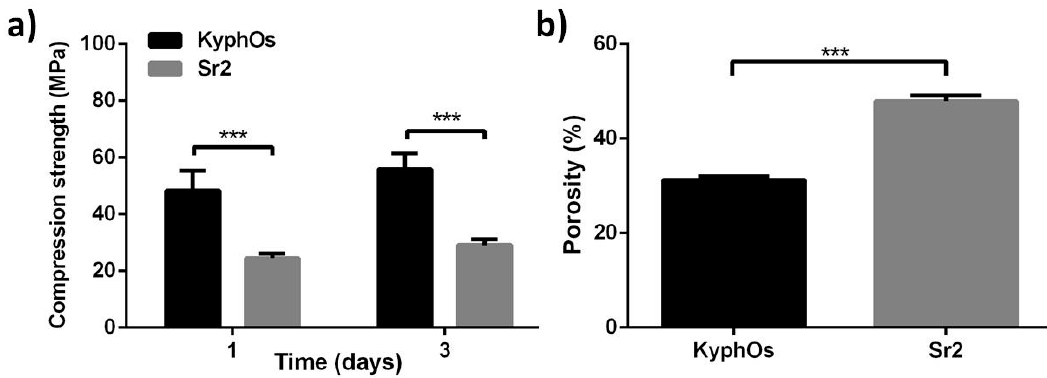
Figure 7. Evaluation of Sr2 cement, compared with control cement: compressive strength ( a ) and porosity after three days of incubation ( b ). *** p < 0.01.